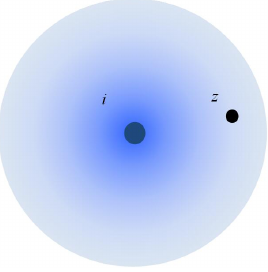
Figure 2. Omni-directional probabilistic sensor.